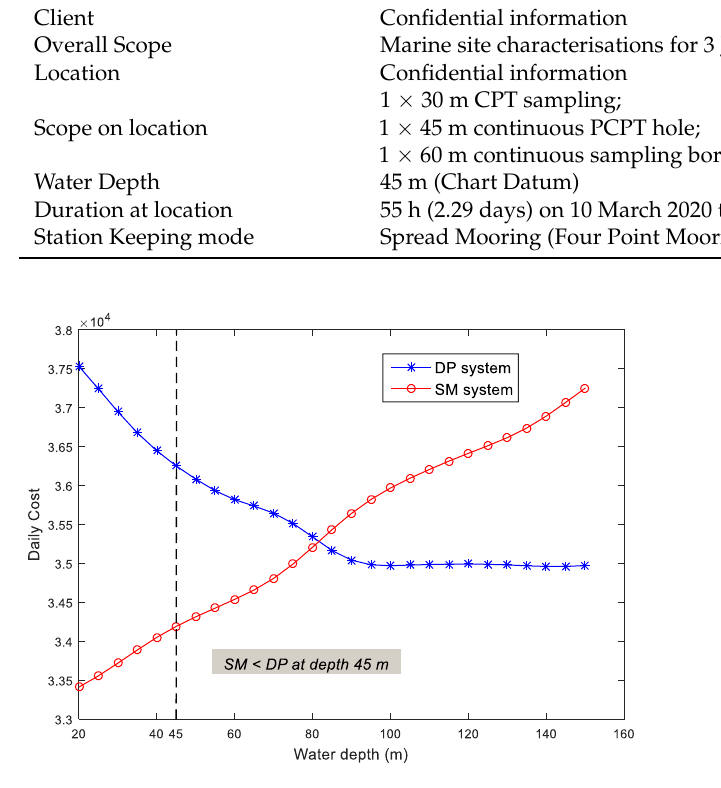
Figure 13. Decision making by ANNs based on total operational cost for the project specified in Table 11.